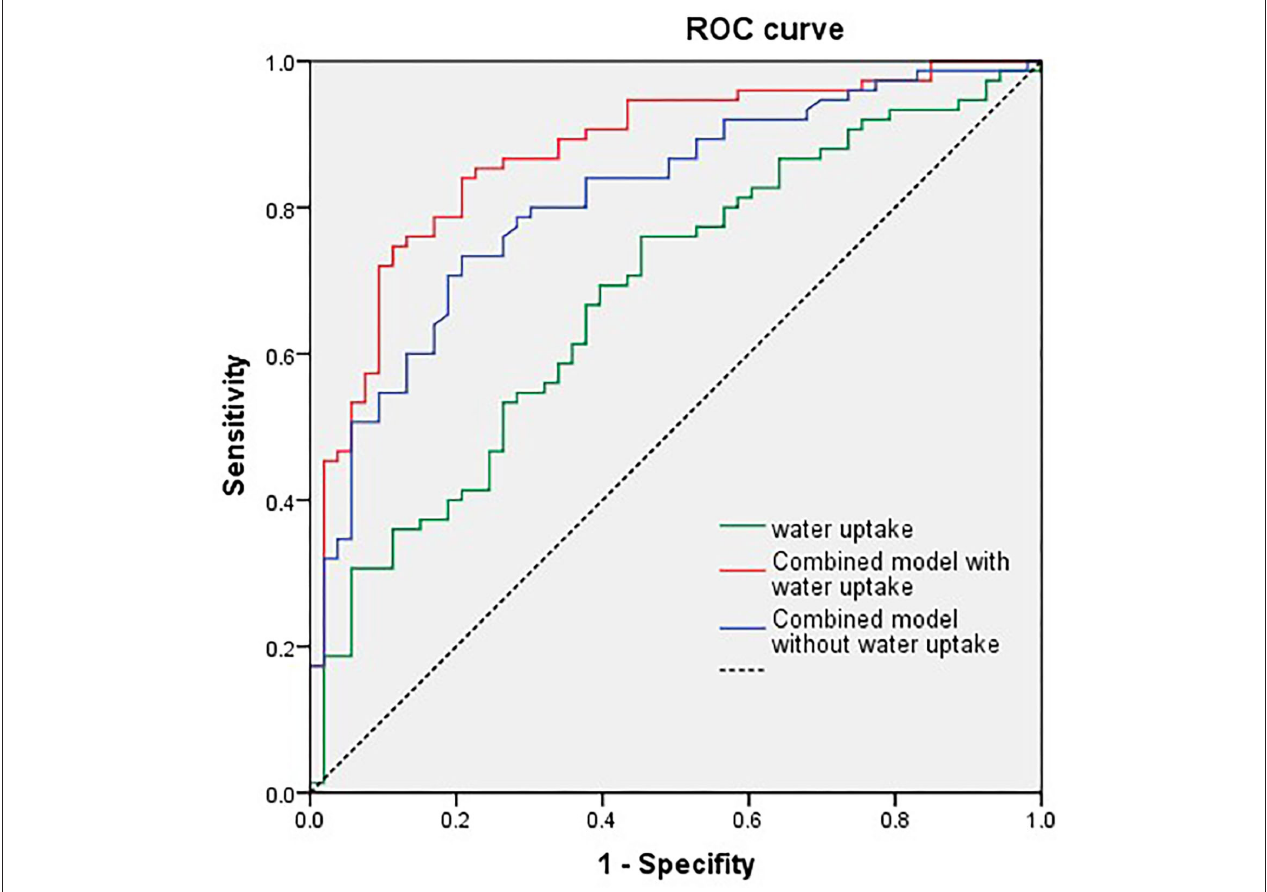
FIGURE 4 | Univariate receiver operating characteristic (ROC) curve analysis of single net water uptake (NWU), combined model with NWU, National Institutes of Health Stroke Scale (NIHSS) score, ischemic core volume, and